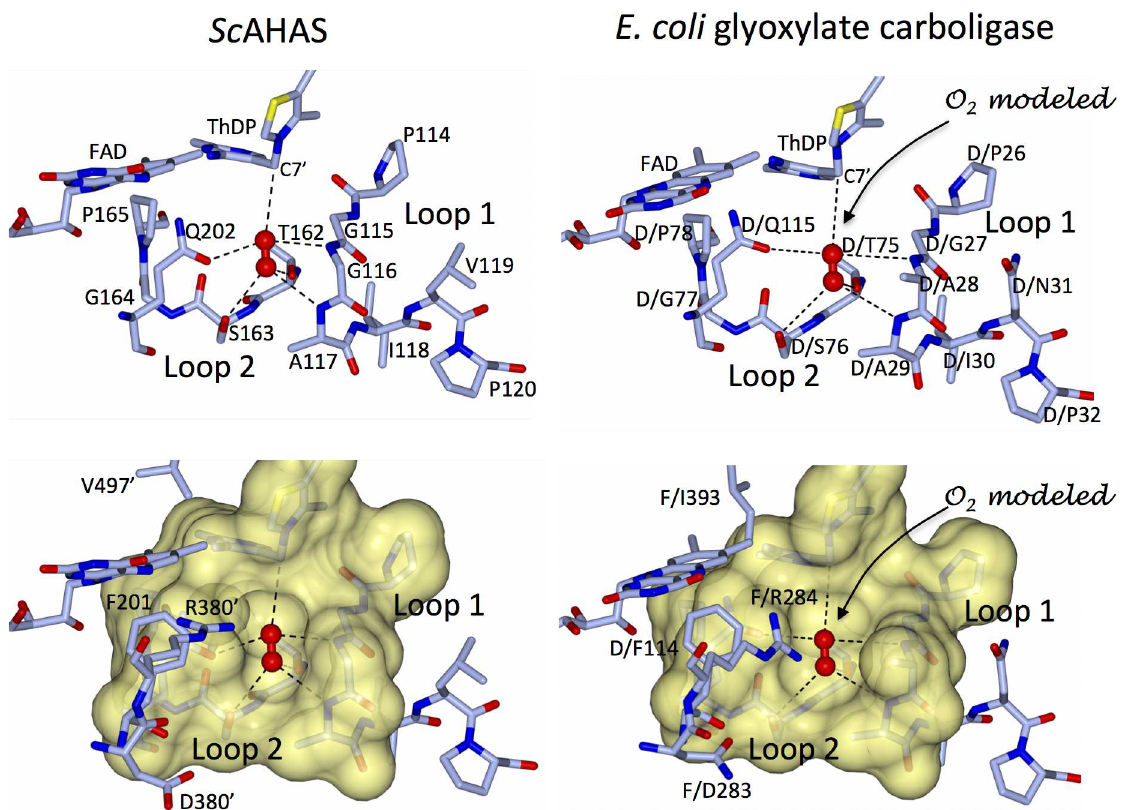
Fig 4. The O 2 (I) binding pocket in Sc AHAS and glyoxylate carboligase from E . coli (EcGCL). The shape, charge and bondingpartners are conservedin both enzymes. Dashed black lines represent the interaction network of O 2 (I), including hydrogenbondsand van der Waals